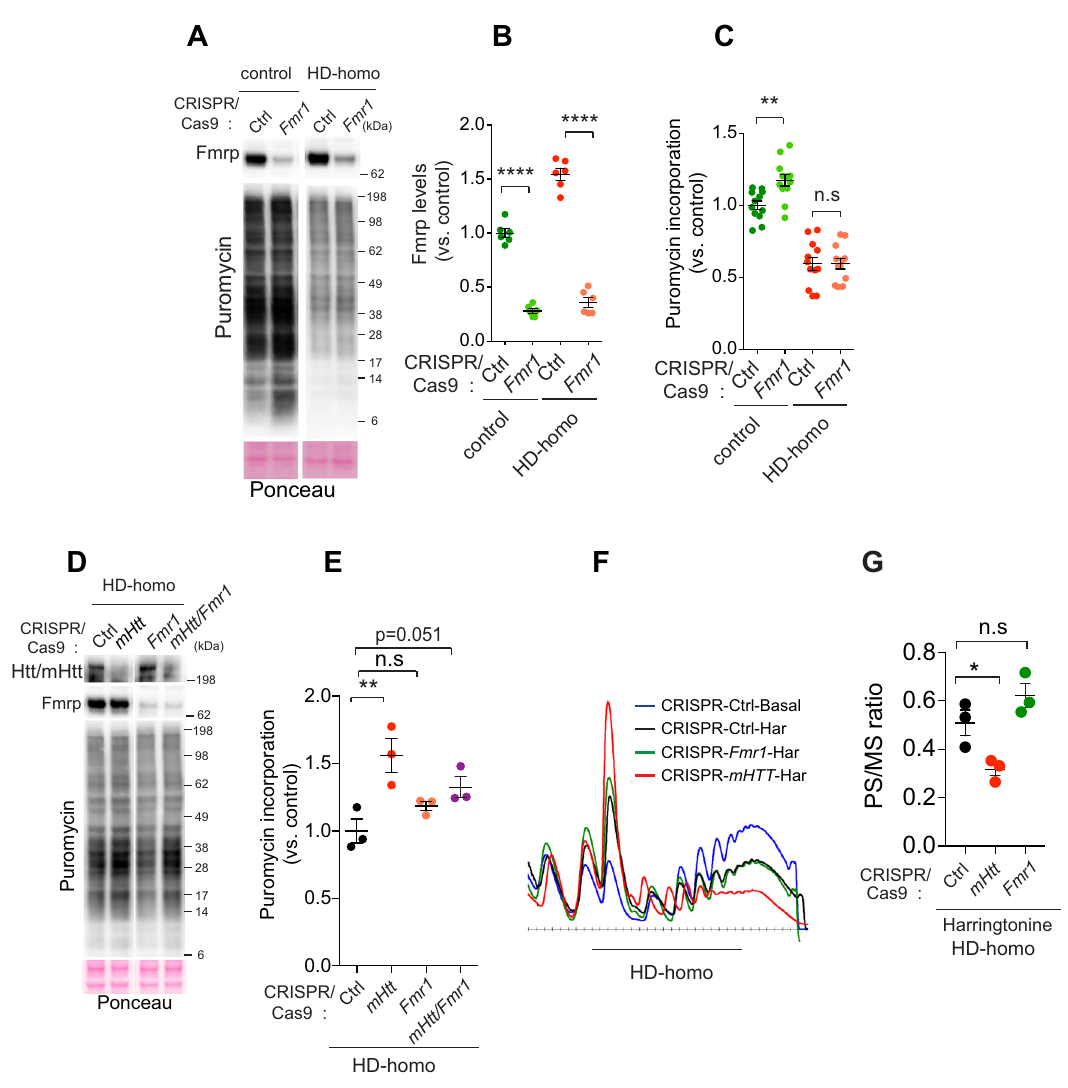
Fig. 5 Fmr1 depletion has no discernible effect on protein synthesis or ribosome stalling in HD cells. A Representative immunoblots performed on CRISPR/Cas9 control (Ctrl) and Fmr1 -depleted mouse striatal cells after puromycin metabolic labeling. B , C Quanti fi cation of blots from A showing FMRP levels ( B ), puromycin incorporation ( C ) in control (Ctrl) and Fmr1 -depleted control, and HD-homo striatal cells. Data are mean ± SEM, ( B n = 6; C n = 12 independent experiments), ** P < 0.01, **** P < 0.0001, by one-way ANOVA followed by Bonferroni ’ s multiple comparisons test, n.s not signi fi cant. D Representative immunoblots performed on Htt or Fmr1 depleted, or Htt/Fmr1 double-depleted HD-homo cells after puromycin metabolic labeling. E Quanti fi cation of the blots from D , showing puromycin incorporation. Data are mean ± SEM ( n = 3 independent experiments), ** P < 0.01, by one-way ANOVA followed by Bonferroni ’ s multiple comparisons test. P = 0.051 by two-tailed Student ’ s t test. F , G Representative polysome pro fi les ( F ) obtained from mHtt or Fmr1 -depleted mouse striatal cells before (basal) and after ribosome run-off assay using harringtonine (2 µ g/ml, 3 min) and their corresponding quanti fi cation ( G ) of polysome to monosome (PS/MS) ratio (area under the curve). Data are mean ± SEM ( n = 3 independent experiments), by one-way ANOVA followed by Tukey ’ s multiple comparison test. n.s. not signi fi cant. Exact P values are reported in the Source Data fi le. Source data are provided as a Source Data fi le. matching RNA (RNA-Seq) (Supplementary Fig. S8). Multiple quality and ribosomal proteins in HD mouse striatal neuronal cells as control measures, such as principal component analysis (Fig. 7A) well as human HD fi broblasts. and Euclidian distance analyses (Supplementary Fig. S9A), showed that the replicates were very similar, with genotype as the principal Global ribosome pro fi ling reveals diverse 5 ′ and 3 ′ ribosome source of differences between the control and the HD cells. Most of occupancy on mRNA transcripts in HD cells . The indications the differential ribosome occupancies (ribosome-protected frag- that mHtt binds and stalls ribosomes led us to posit that overall ments, RPF) were mapped to annotated protein-coding open-read- global ribosome occupancy may be altered in HD. We investigated ing frames, with a 29-nt expected triplet nucleotide periodicity and this using a global ribosome pro fi ling approach 91 – 94 . We treated cells ribosome occupancy at the start and stop codon for control, HD-het, with cycloheximide, as described previously 95,96 , and isolated poly- and HD-homo (Fig. 7B and Supplementary Fig. S9B, C). Thus, we somes from three biological replicates of wild-type control striatal generated a high-quality Ribo-Seq library of control, HD-het, and cells and HD-het and HD-homo mutant striatal cells. We conducted HD-homo striatal cells for subsequent bioinformatics analysis. ribosome pro fi ling to prepare ribosome footprints (Ribo-Seq) and NATURE COMMUNICATIONS| (2021) 12:1461